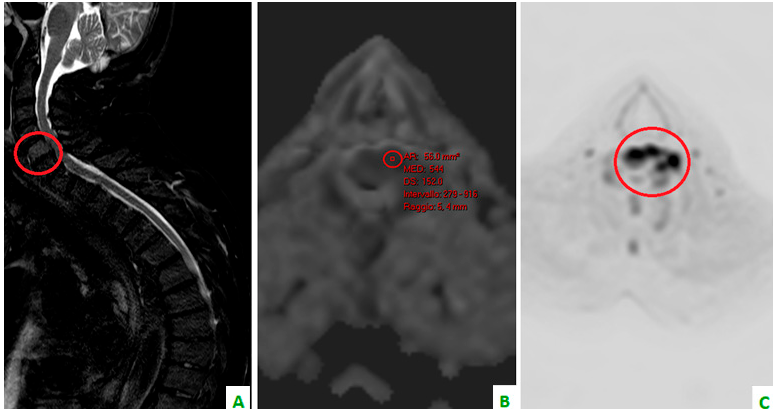
Figure 4. Focus on the red circles: ( A ) DIXON T2 weighted in the sagittal plane showing bone cervical metastasis (C5) ( B ) a low apparent diffusion coefficient (ADC) value in the same level, and ( C ) a restriction of diffusivity.